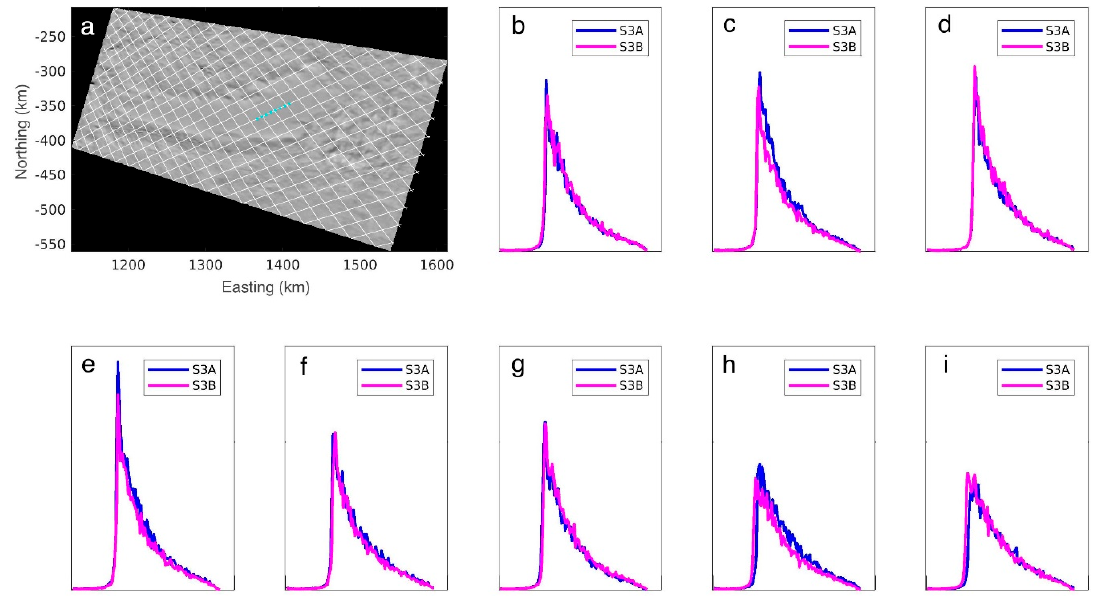
Figure 13. Repeatability of S3A and S3B tandem acquisitions above subglacial Lake Vostok, East Antarctica. Panel a : the locations of satellite tracks (white) and the acquisitions shown in panels b – i (turquoise); the background image is taken from the MODIS Mosaic of Antarctica. Panels b – i : co-located, contemporaneous, and co-orientated (within 150 m) tandem phase waveforms acquired by S3A (blue) and S3B (magenta), demonstrating excellent agreement between S3A and S3B acquisitions.